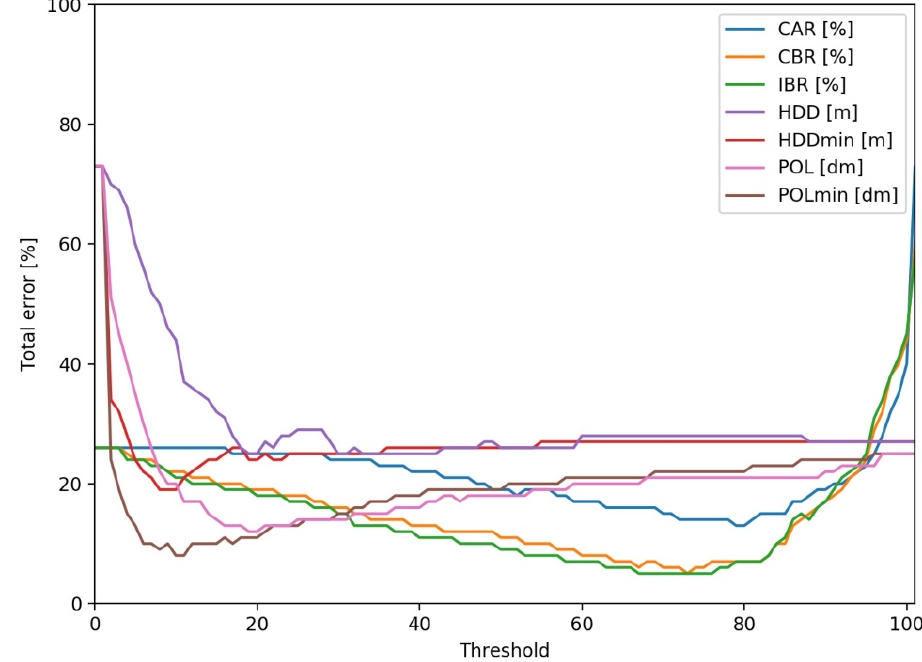
Figure 10. Overview of the determination of the optimal threshold values of all matching methods. For better comparability, the values of PoLiS (POL) and PoLiSmin (POLmin) are shown as decime- ters.